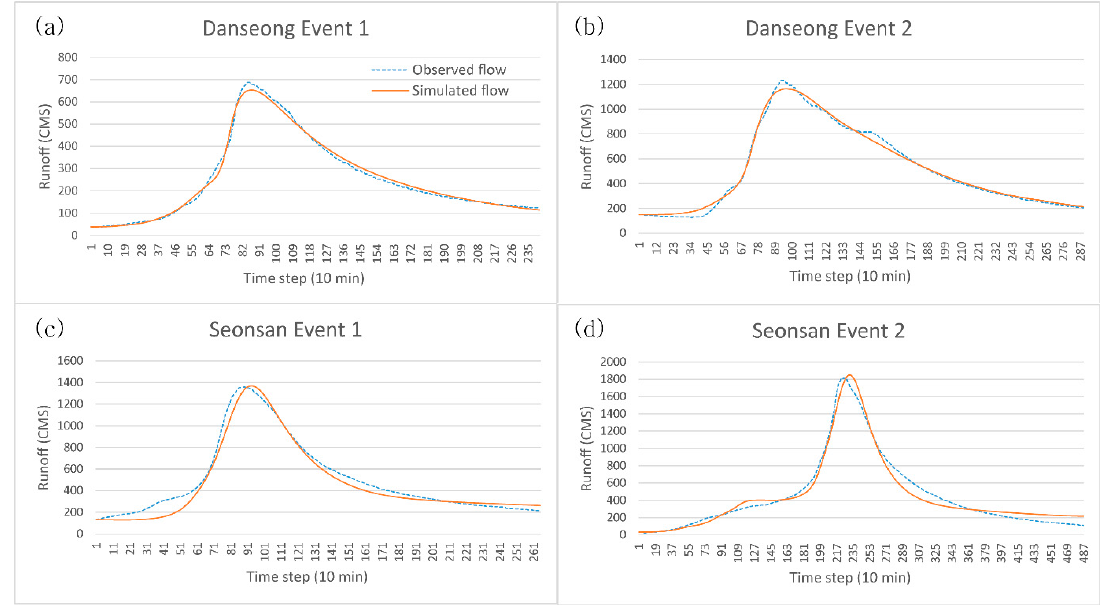
Figure 3. Observed and simulated hydrographs for parameter calibration periods. ( a , b ) show the observed and simulated flow of the rainfall event 1 and 2 of Danseong catchment, respectively. ( c , d ) show the observed and simulated flow of the rainfall event 1 and 2 of Seonsan catchment, respectively. Table 4. Model performance statistics a .